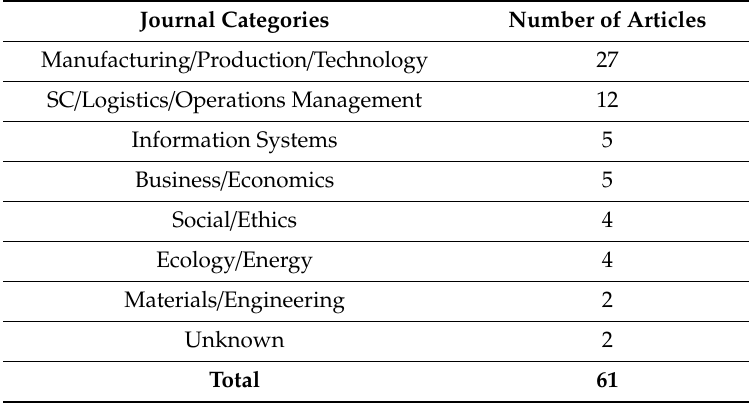
Table 2. Journal